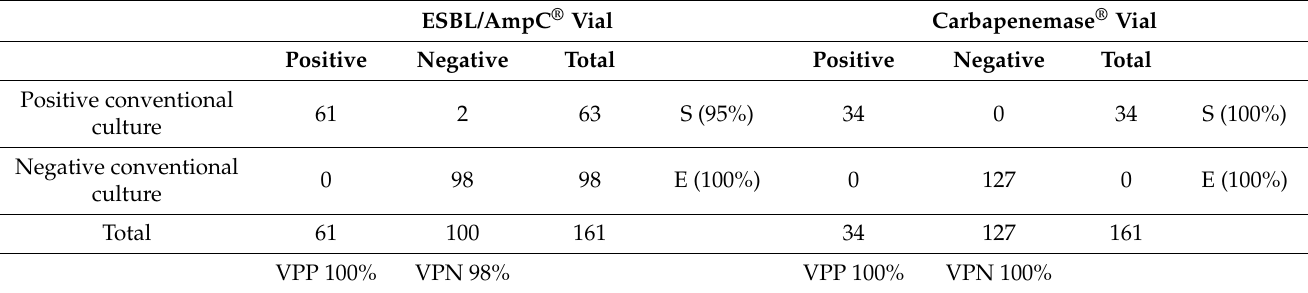
Table 3. Operational characteristics of the ESBL/AmpC and HB&L Carbapenemase kit